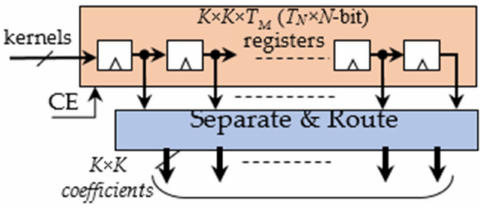
Figure 3. The Kernel Bu ff er.